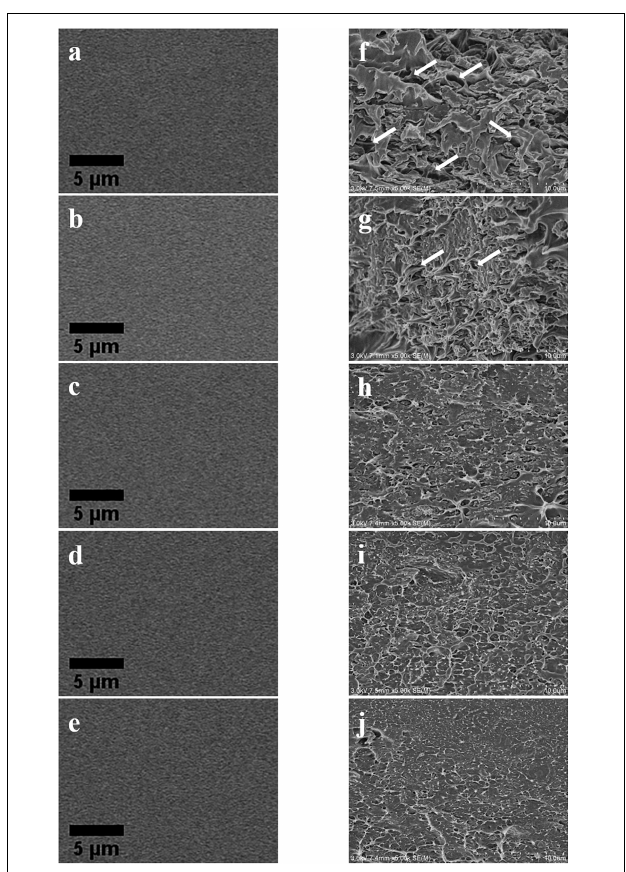
FIGURE 8 | SEM images of surface and cross section of composite films. (a) ∼ (e) Surface; (f) ∼ (j) cross section. Amount of ASCNC: (a) and (f) 0%; (b) and (g) 2%; (c) and (h) 6%; (d) and (i) 9%; (e) and (j)